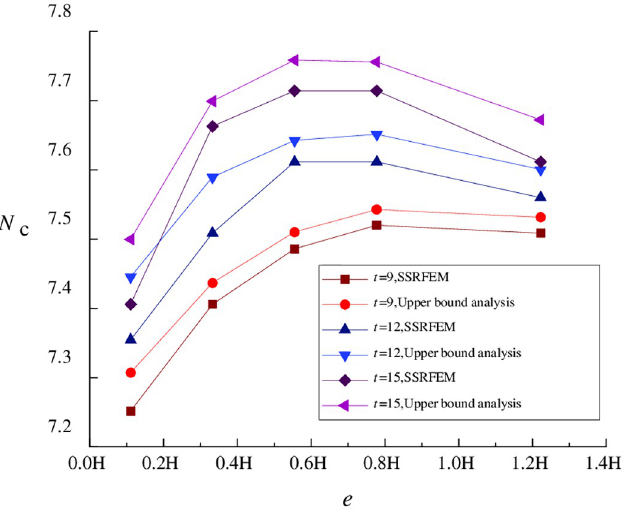
Fig 2. Relationships of N c with e and t ( H/B =